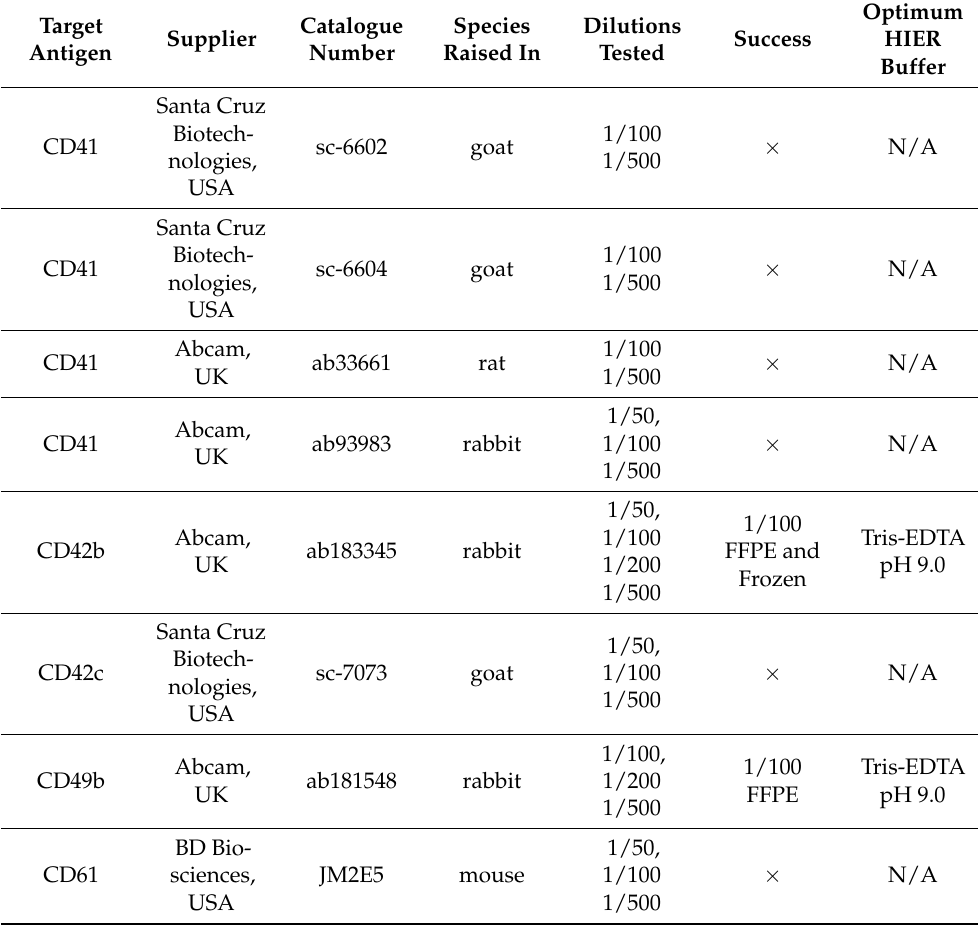
Table 4. Platelet-specific antibodies tested in pig